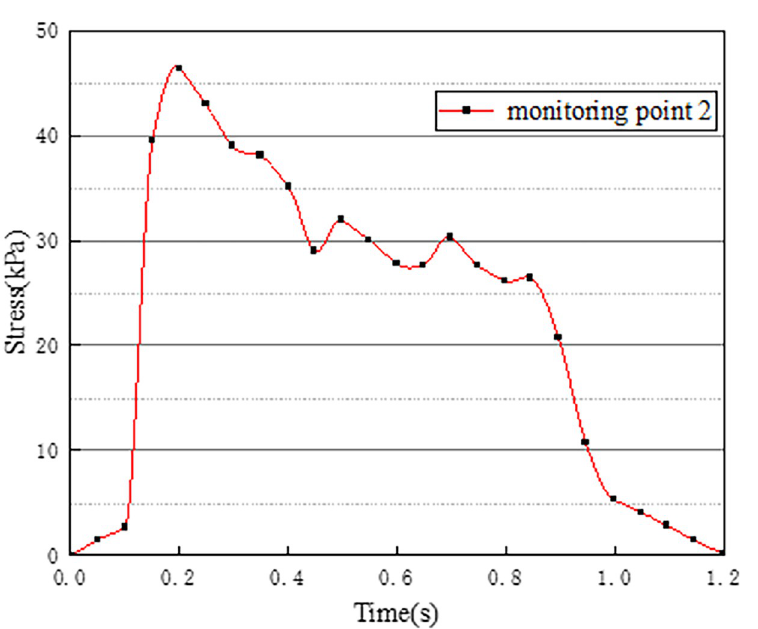
Fig 4. Stress time history curve of monitoring point 2.